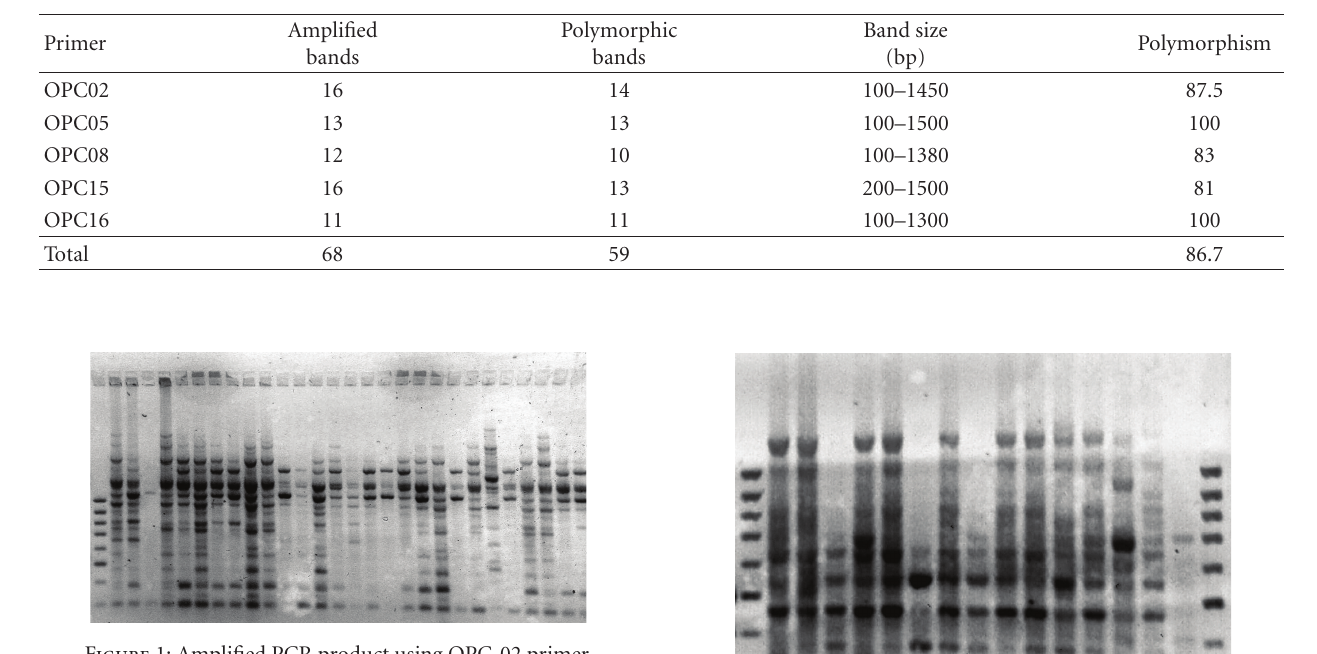
Table 2: Statistics of polymorphic primers for investigated populations.